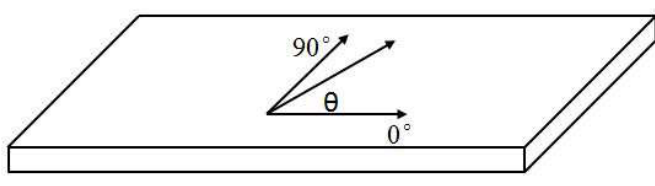
Figure 3. Plying angle definition of the